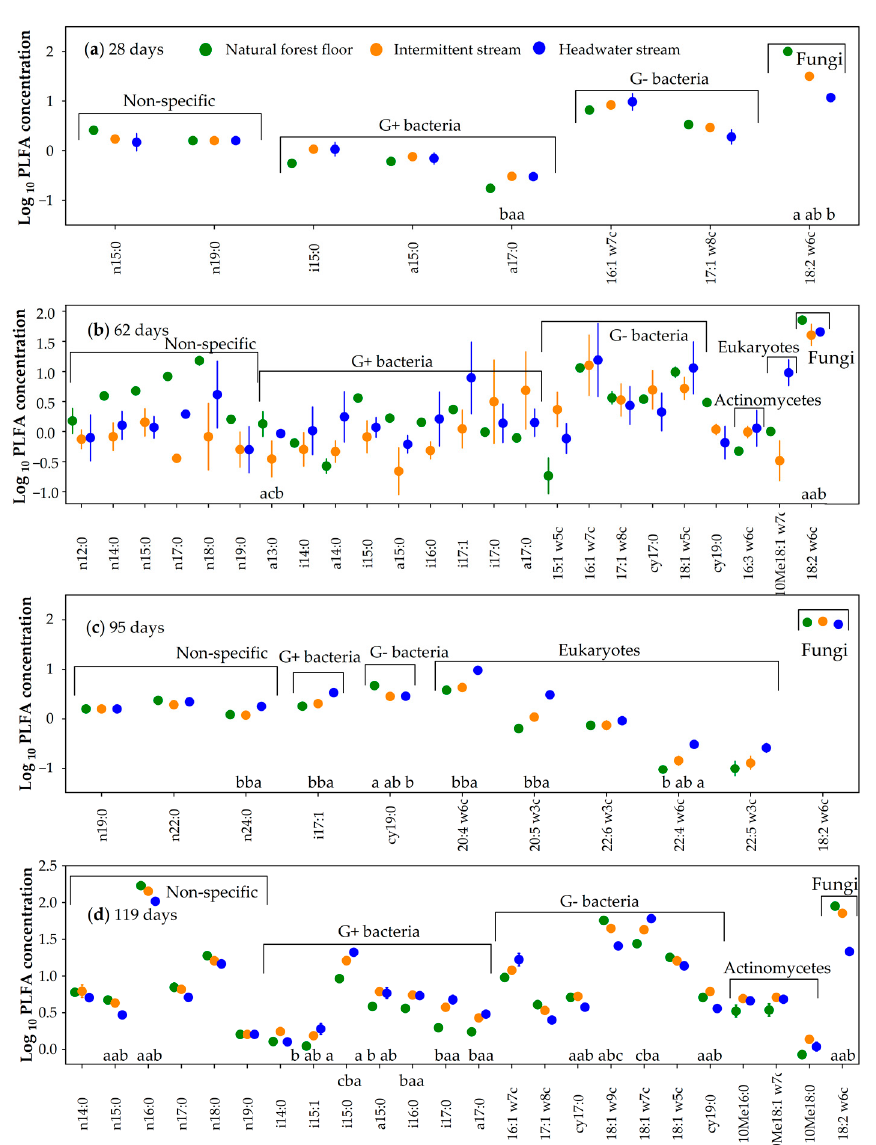
Figure 4. Concentrations of individual PLFA on ( a ) the 28th day of decomposition and ( b ) the 62nd day of decomposition and ( c ) the 95th day of decomposition and ( d ) the 119th day of decomposition leaf litter. Letters indicate significant differences among transect regions ( p < 0.05). Dots indicate the mean and whiskers the standard error.